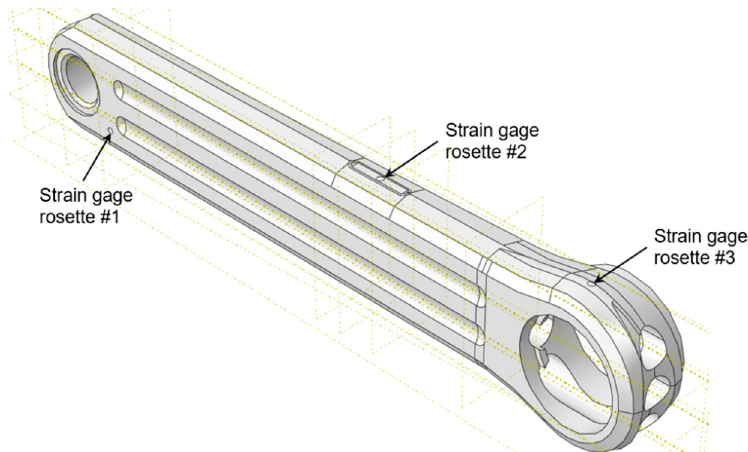
Figure 10. Finite element of the crank arm.